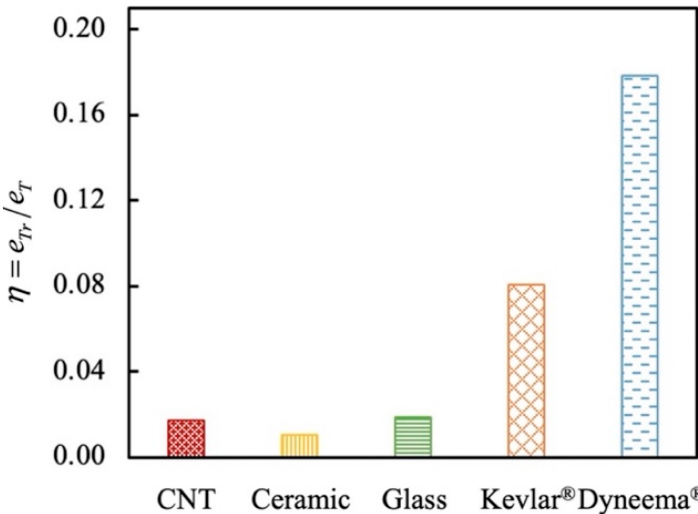
Figure 16. Comparison of η for different fibers.